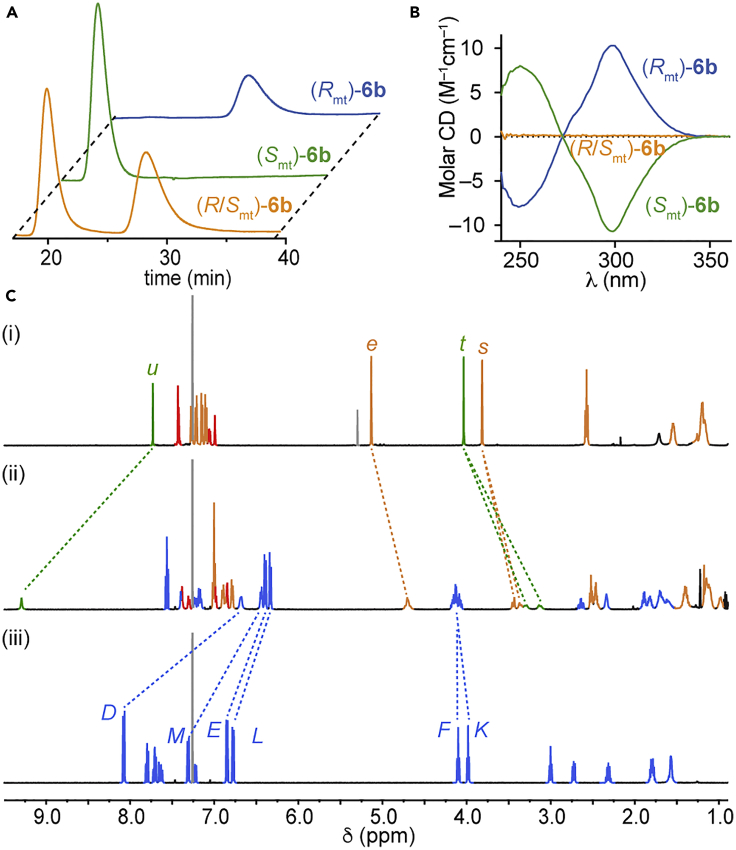
Characterization of Catenanes 6b(A) Analytical chiral stationary phase HPLC chromatograms (RegisCell, 98:2 hexane-iPrOH, 0.5 mL/min) of (Rmt)-6b (blue), (Smt)-6b (green), and racemic 6b (orange).(B) CD spectra (35.0 μM in CHCl3, 293 K) of (Rmt)-6b (blue), (Smt)-6b (green), and racemic 6b (orange).(C) Partial stacked 1H NMR spectra (500 MHz, 298 K, CDCl3) of (i) the corresponding non-interlocked triazole macrocycle of catenane 6b, (ii) catenane (Smt)-6b, and (iii) macrocycle 2b. Selected signals are assigned and color coded (see Schemes 1 and 2). Signals corresponding to macrocycle 2b are all shown in blue for clarity.